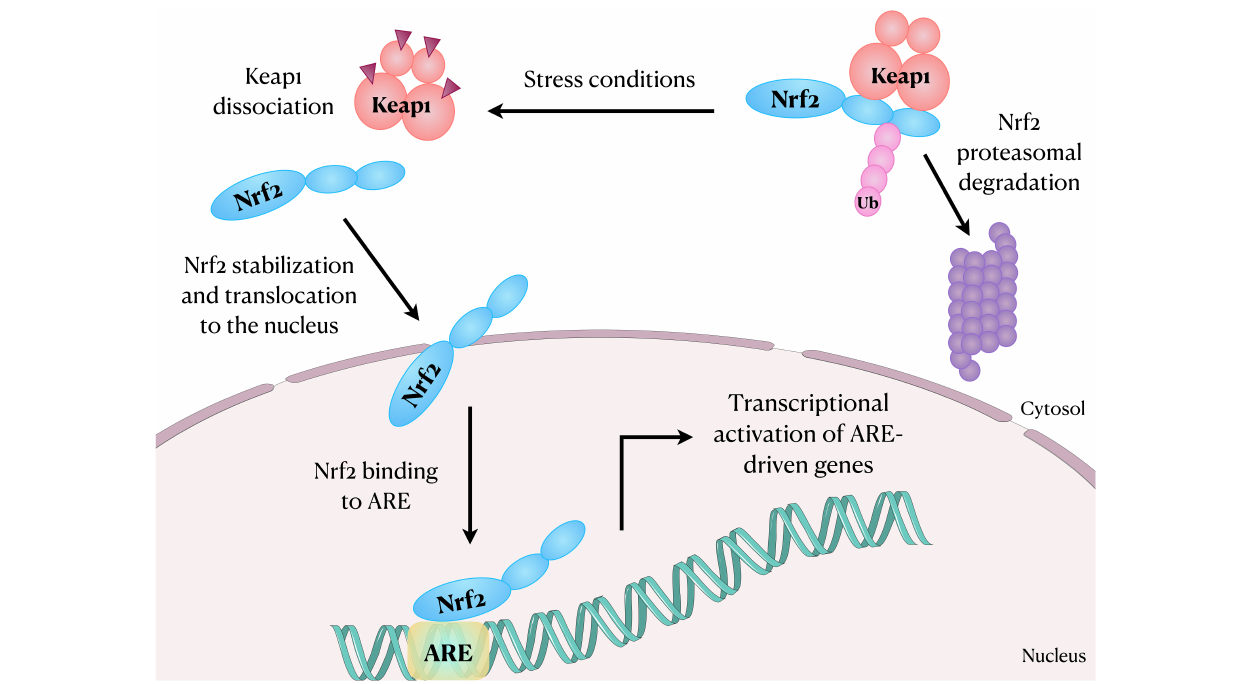
FIGURE 1 | Schematic representation showing Nrf2 translocation to the nucleus after dissociation from its inhibitory protein Keap1. In the nucleus, Nrf2 binds and activates ARE in the DNA, regulating the expression of several genes, including those involved in oxidative stress responses. ARE, antioxidant response element; Keap1, Kelch-like ECH associated protein-1; Nrf2, nuclear factor erythroid-2-related factor 2; Ub, Ubiquitin.